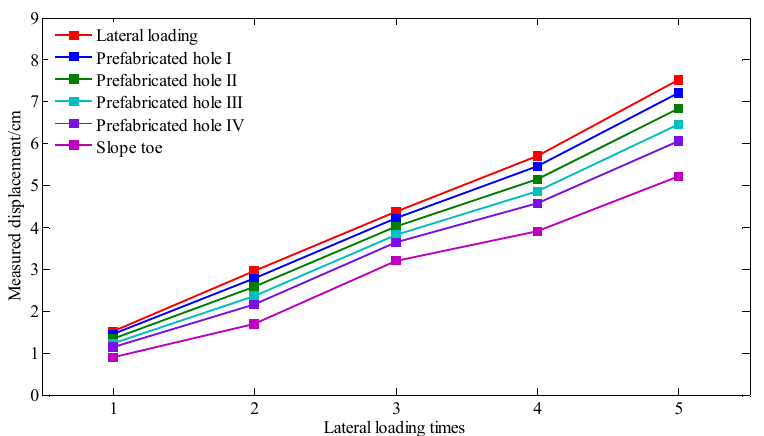
Figure 11 . Lateral loading displacement. Figure 11. Lateral loading displacement.